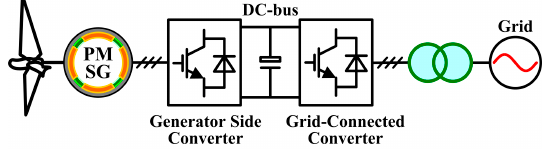
Figure 1. Direct-drive wind power generation system.